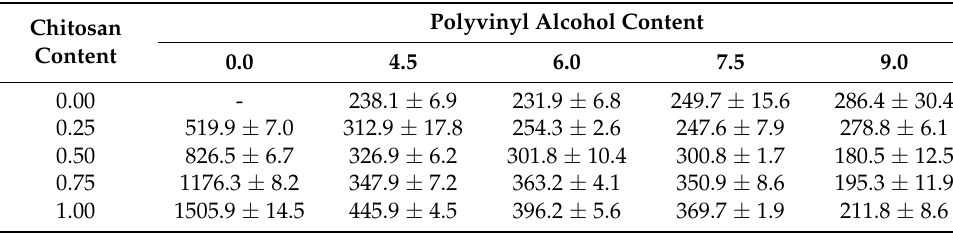
Table 3. Electrical conductivity ( µ S · cm − 1 ) of pure CS solutions and CS/PVA mixtures (% w / w